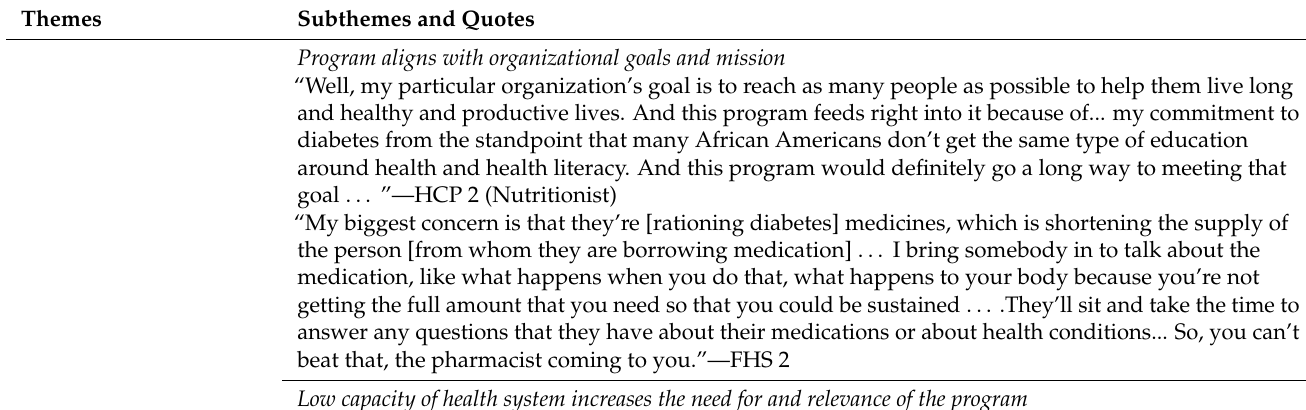
Table 3. Stakeholders’ Perceptions of Peers